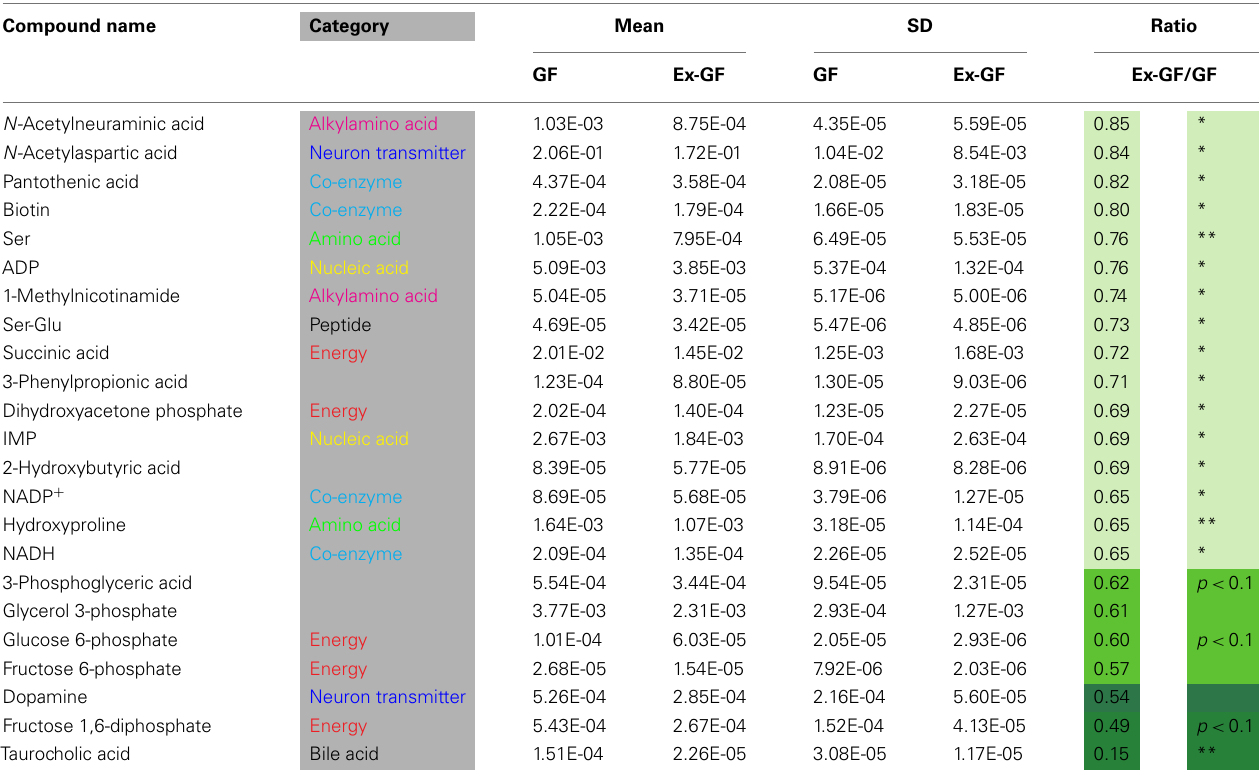
Table 2 | Metabolites whose concentrations were lower in the cerebral metabolome of Ex-GF mice than in that of GF